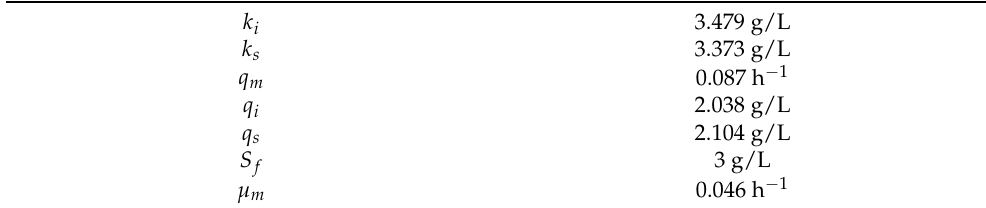
Table 1. Nominal values of model parameters